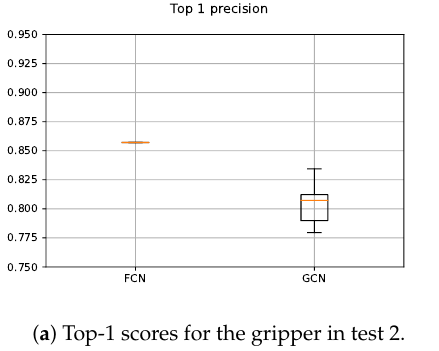
Figure 18. Obtained precision scores per confidence percentiles for the gripper models in Test 2.